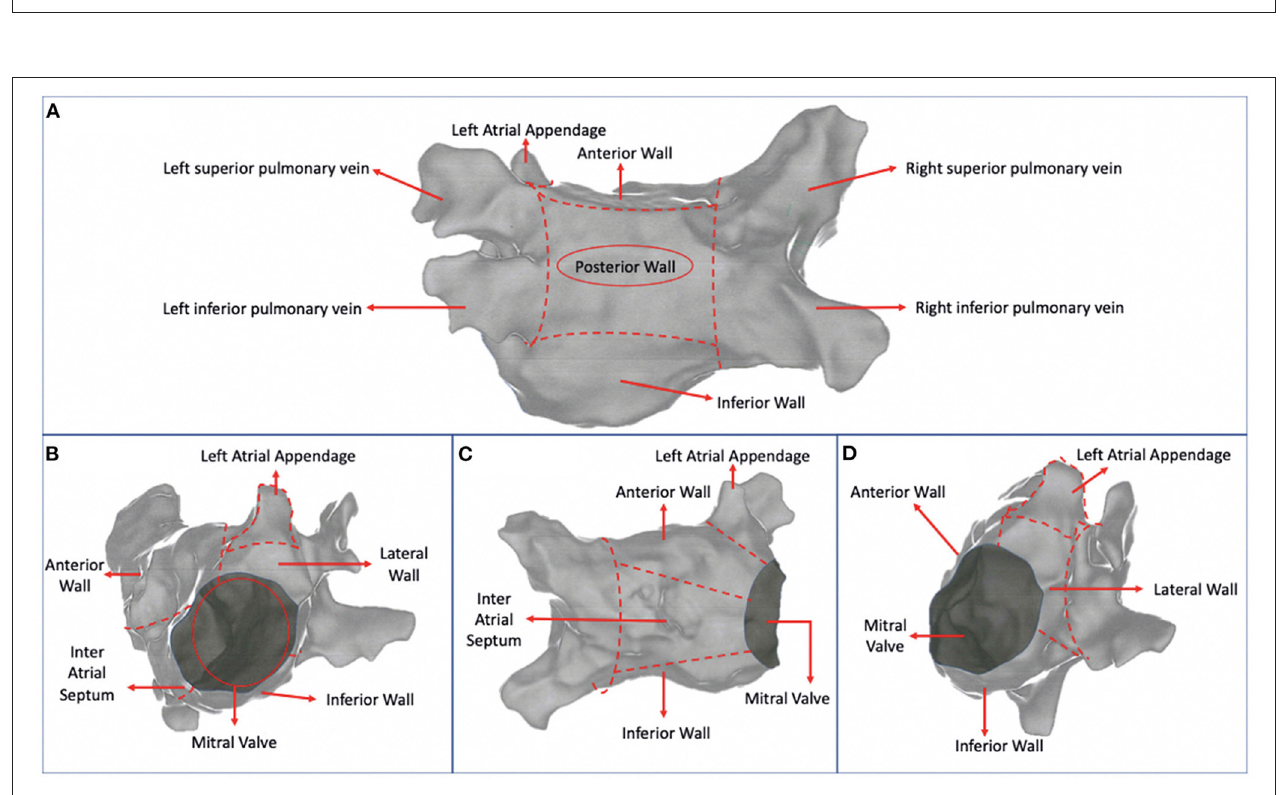
FIGURE 1 | Study design. LAA, Left Atrial Appendage; PVI, Pulmonary Vein Isolation; PVI + , Pulmonary vein isolation with ablation at additional locations except the left atrial appendage; LAAi, Left atrial appendage complete isolation; LAAa, Left Atrial appendage ablation or partial isolation.